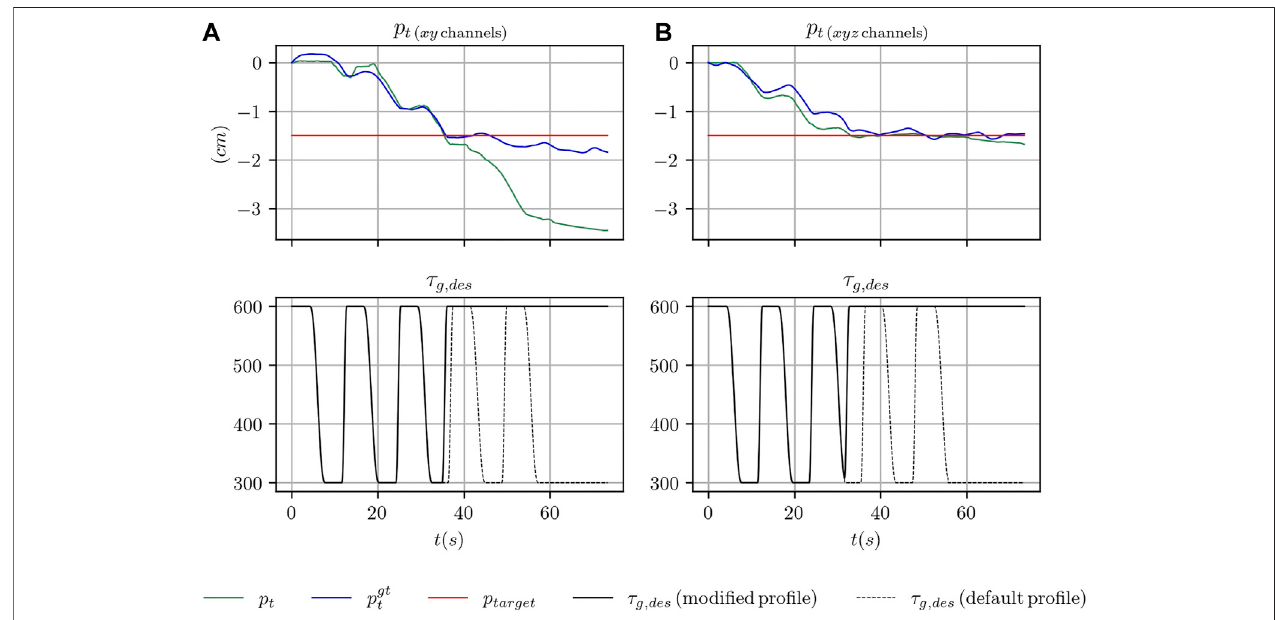
FIGURE 9 | Sample trajectories from one of the experiments on using the learned fi lter in a practical scenario with the box-shaped object. In (A) , the results are shown when using the xy tactile channels, in (B) when using the xyz tactile channels.